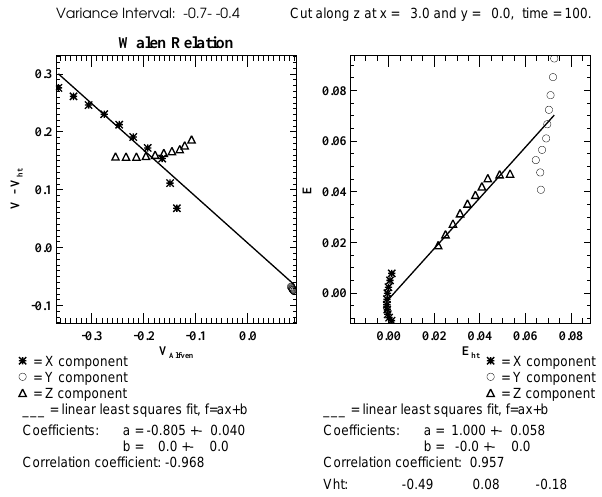
Fig. 12. Wal´en relation and deHoffman-Teller test results for the dayside plasma